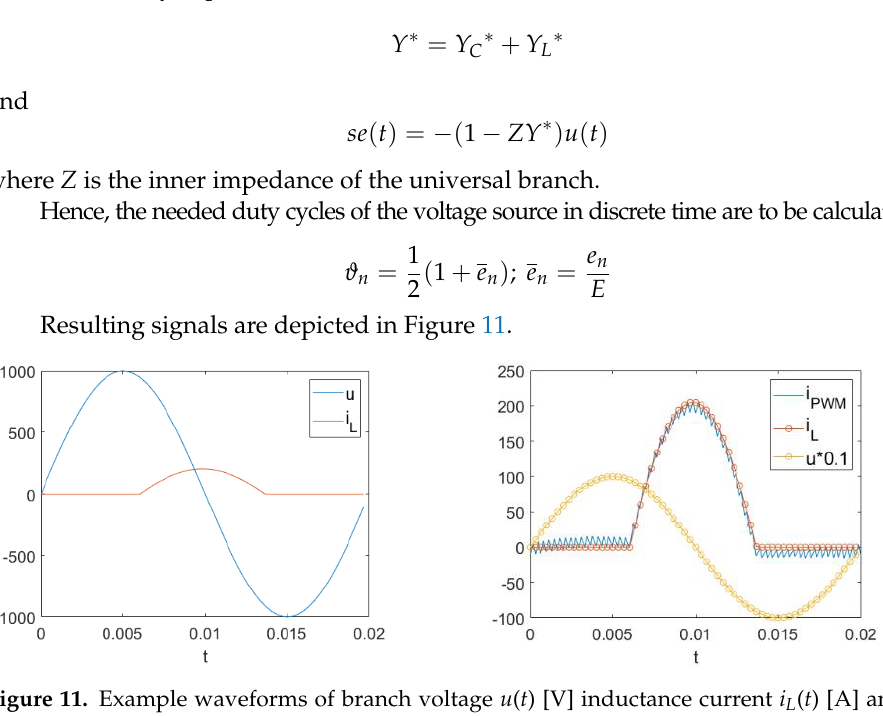
Figure 11. Example waveforms of branch voltage u ( t ) [V] inductance current i L ( t ) [A] and PWM current i PWM for N = 60.